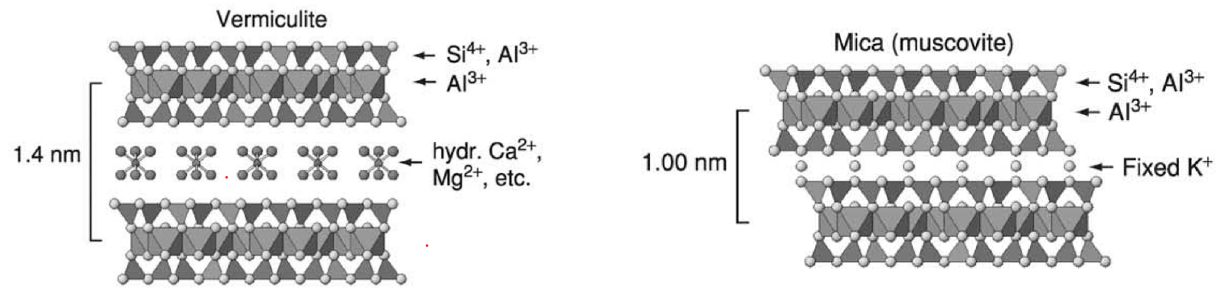
Figure 1. Molecular structure of vermiculite and mica. Font: Schulze (2005) [12].